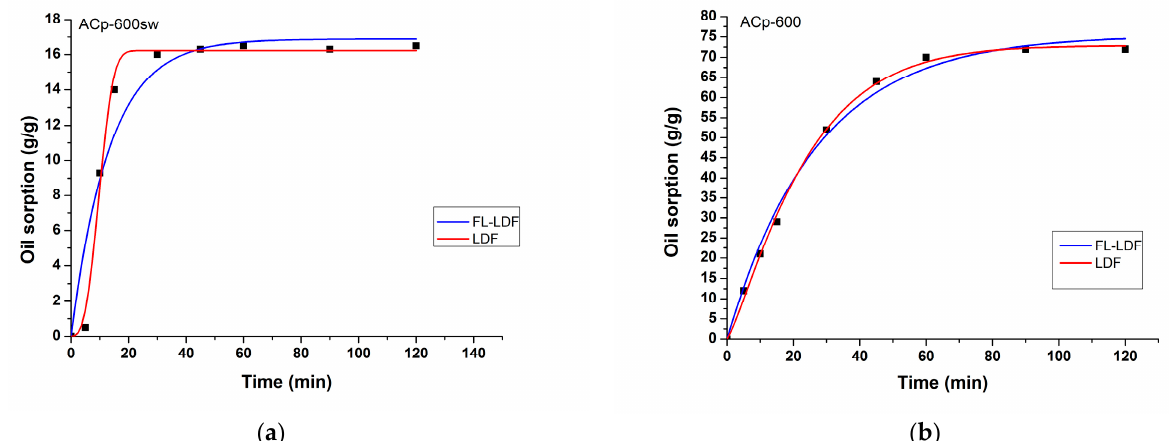
Figure 6. Comparison of experimental data with oil sorption kinetic models, Fractal-Like Linear Driving Force (FL-LDF) and Linear Driving Force (LDF, bottom for. ( a ) ACp-600 in the oil/seawater system ( b )ACp-600 in oil. Table 2. Parameters of the FL-LDF and LDF model for ACp-600 in oil and oil/seawater systems.